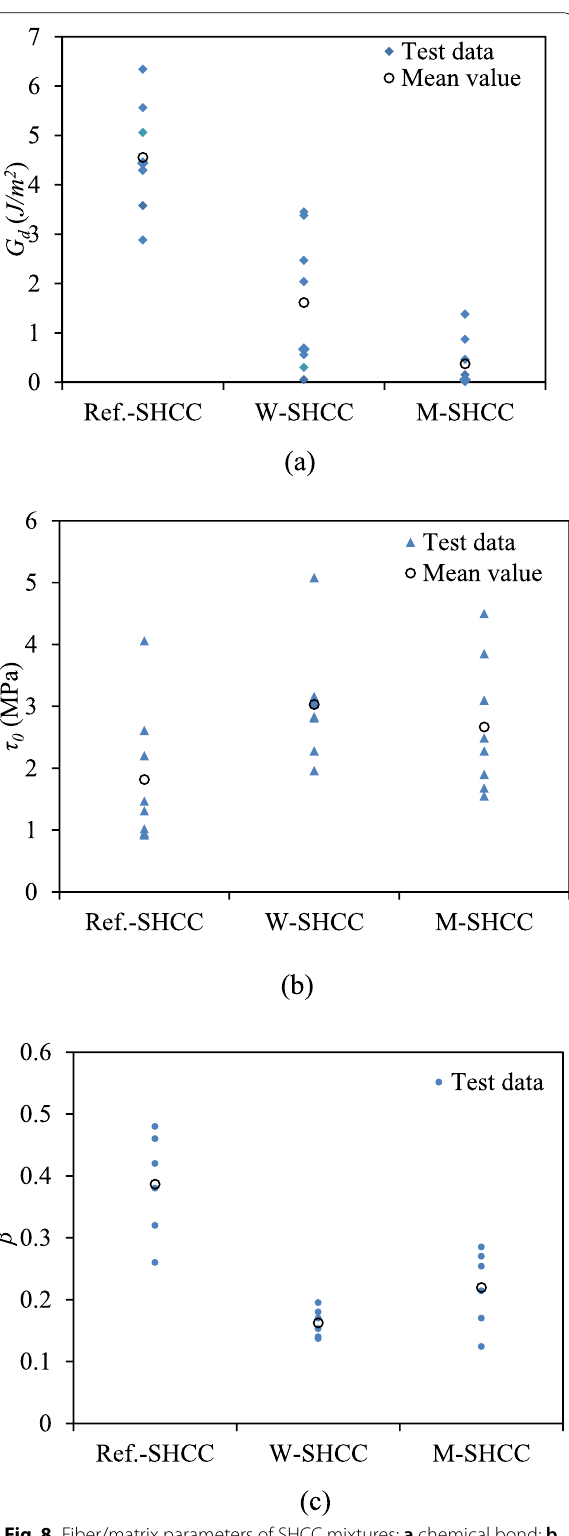
Fig. 8 Fiber/matrix parameters of SHCC mixtures: a chemical bond; b frictional bond; c slip-hardening